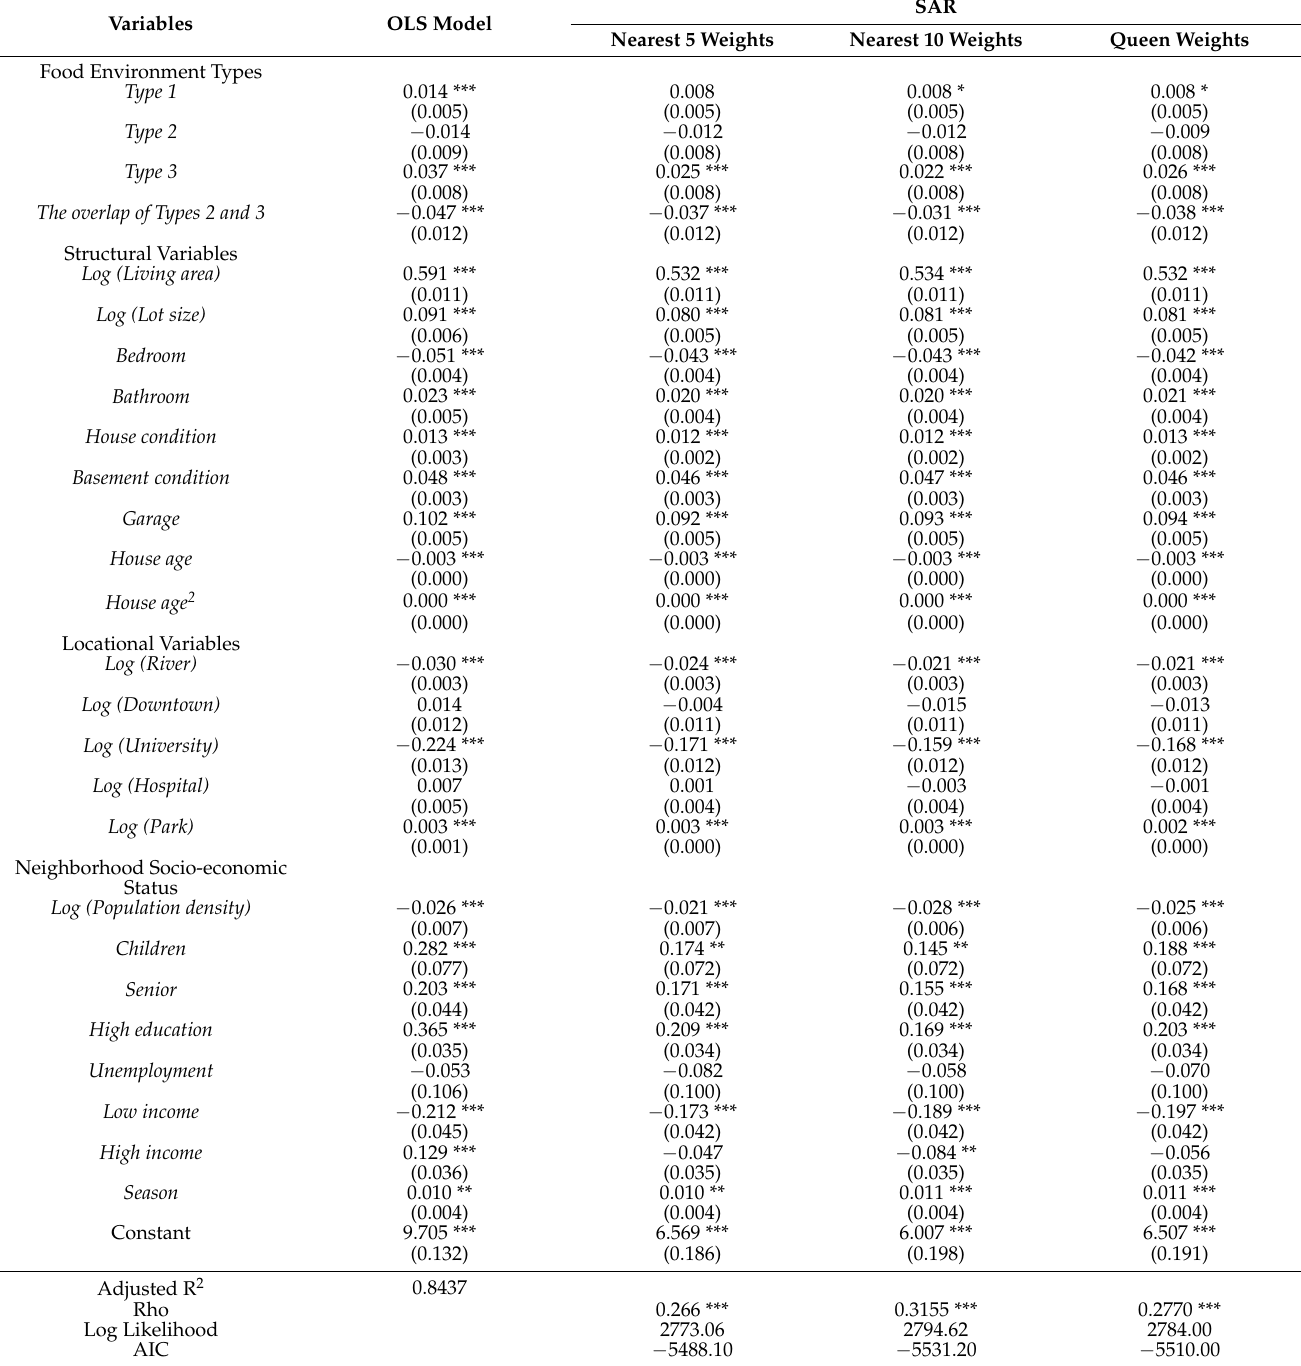
Table 3. Estimation Results of Different Hedonic